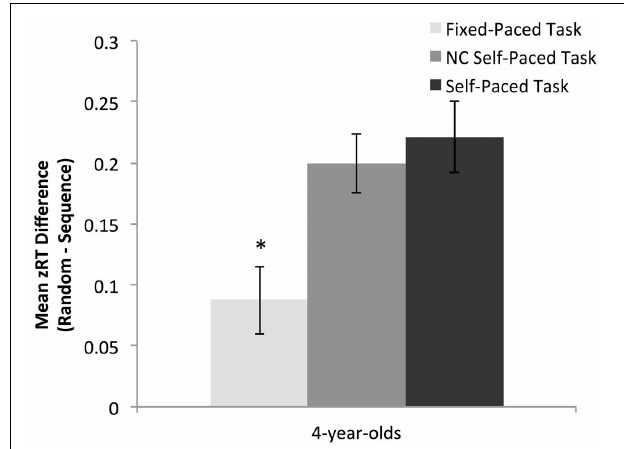
FIGURE 3 | Magnitude of the overall learning effect for preschoolers across task (data from experiment 1 and 2). Learning for preschoolers was equivalent on the two self-paced tasks and significantly greater than learning in the fixed-paced condition. ∗ p < 0 . 05.